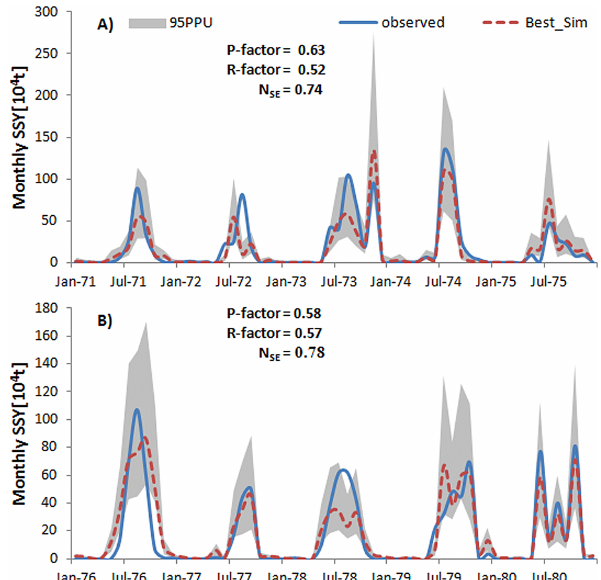
Figure 7. The results for behavioral parameters on the 95% monthly suspended sediment prediction uncertainty band at the Ke- jie hydrological station. Calibration and validation results are shown in Fig. 7a and b.